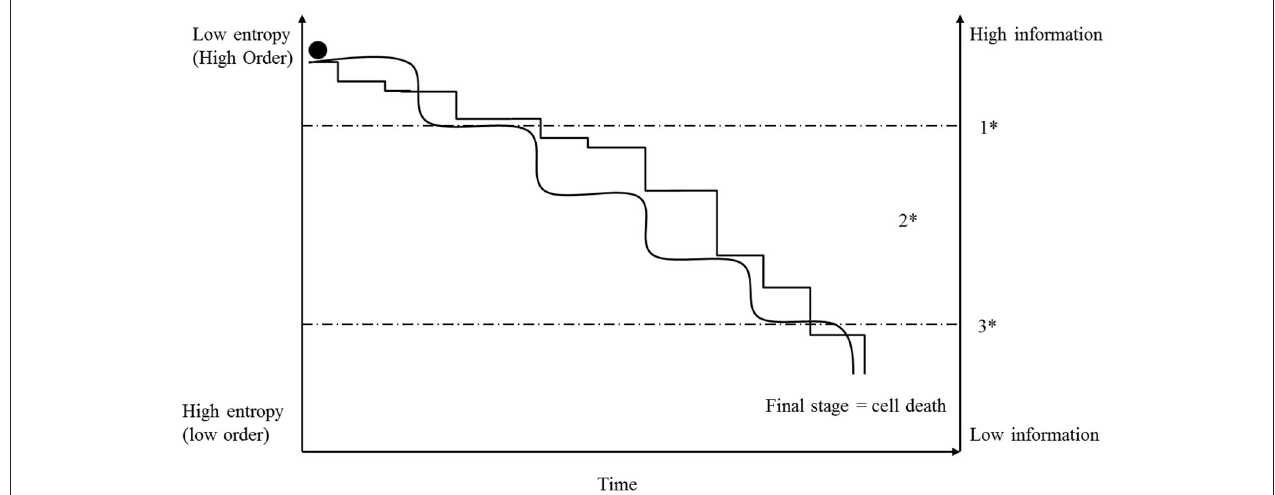
FIGURE 3 | Initially, a cell possesses a high order and information level (low entropy). Because of replication mistakes or for other intra- or extra-cellular reasons, mutations take place and entropy of information accumulates step-by-step (angled line). The consequence of a mutation depends on the importance of the affected (nucleotide) sequence and is symbolized in the graph by the different heights of the steps. In contrast, aneuploidy and CIN can affect several hundred genes in one event and for that reason, accumulation of entropy can increase in larger steps (rolling steps). However, once entropy of information exceeds a specific breaking point (1*), so many initially ordered mechanisms are irreversibly disturbed that the cell transitions into a metastable state (2*). In that state, the fate of the cell depends on its ability to achieve an acceptable stability in accordance with available energy and matter (see text). Many cells exceed the breaking point (3*) and die, but a few will be able to establish a metastable order based on a lower information content and may display all the characteristics of a cancer cell (see Figure 2 ). In that context, it is very surprising how many mutations and chromosomal aberrations cancer cells can tolerate and survive.